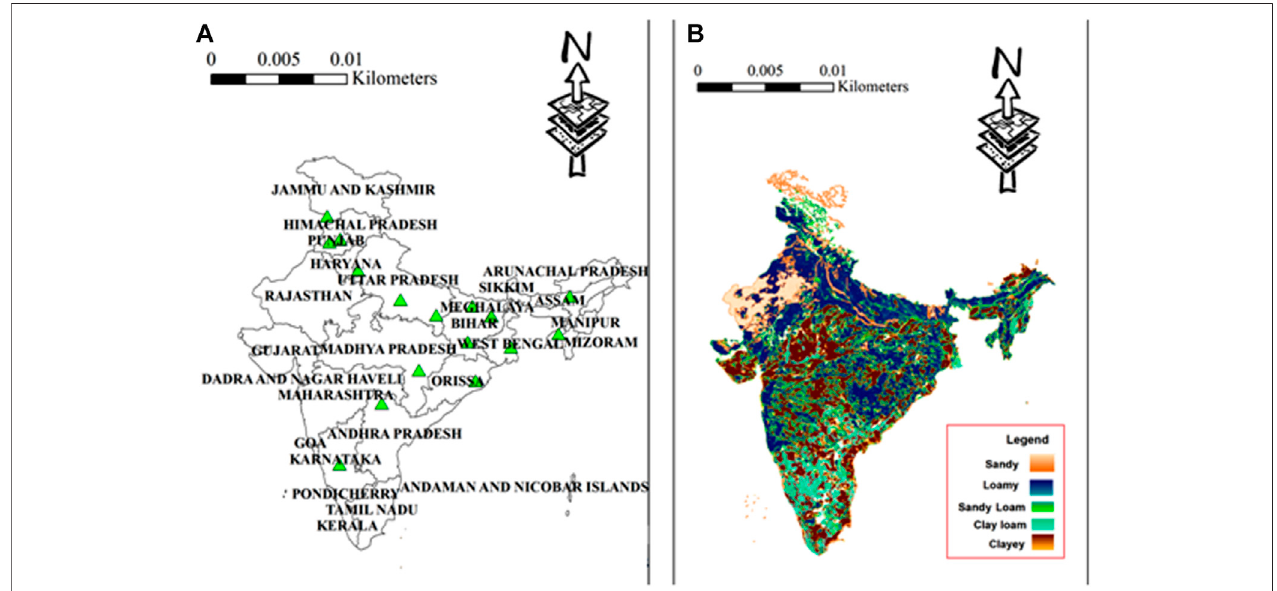
FIGURE 1 | (A) Location map showing major study sites of India; (B) different soil types predominant in India. Major study sites: Kanpur, Uttar Pradesh (sandy loam); Pusa, Bihar (silty clay); Sabour, Bhagalpur (sandy loam); Tripura, India (sandy clay loam); Sabour, Bhagalpur (clayey); Kathalagere, Bangalore (sandy clay); Ludhiana, Punjab (sandy loam); New Delhi, India (sandy loam); Pusa, Bihar (silt loam); Cuttack, Odisha (sandy clay loam); Khudwani, Kashmir (silty clay loam); Ranchi, Jharkhand(sandy clayloam);Tejpur,Assam(sandy loam);Ludhiana, Punjab (loamy sand);Dhiansar,Jammu(sandyloam); Raipur,Chhattisgarh(sandyclayloam); Varanasi, Uttar Pradesh (loamy); Kanpur, Uttar Pradesh (loamy); Sabour, Bhagalpur (sandy clay loam); and Kalayani, West Bengal (clayey).